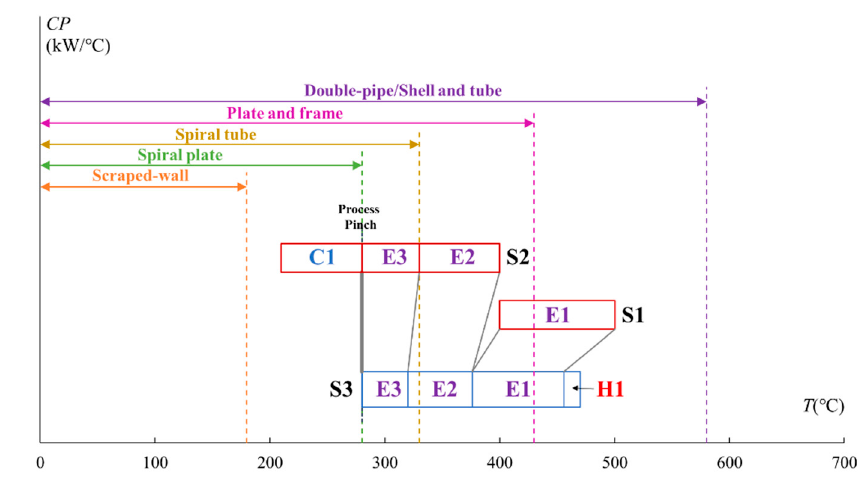
Figure 5. SRTGD-STR of the third retrofit plan for Example 1.